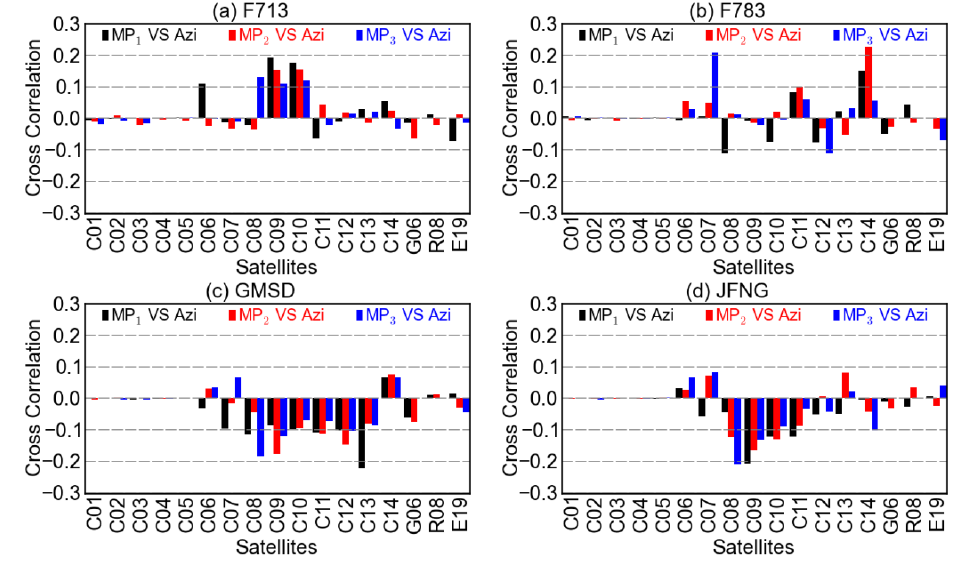
Figure 7. Cross-correlations between the code multipath combinations MP 1 (black), MP 2 (red), MP 3 (blue) and the azimuths at stations ( a ) F713, ( b ) F783, ( c ) GMSD, and ( d ) JFNG.